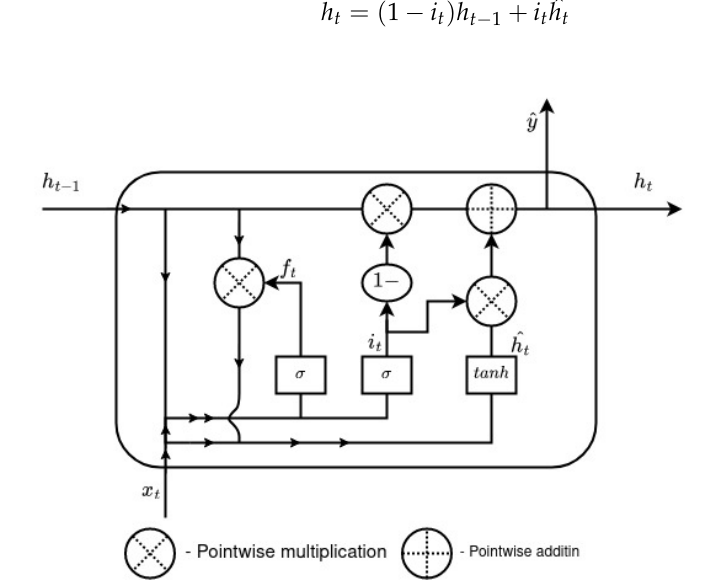
Figure 2. Structure of a gated recurrent unit (GRU) cell